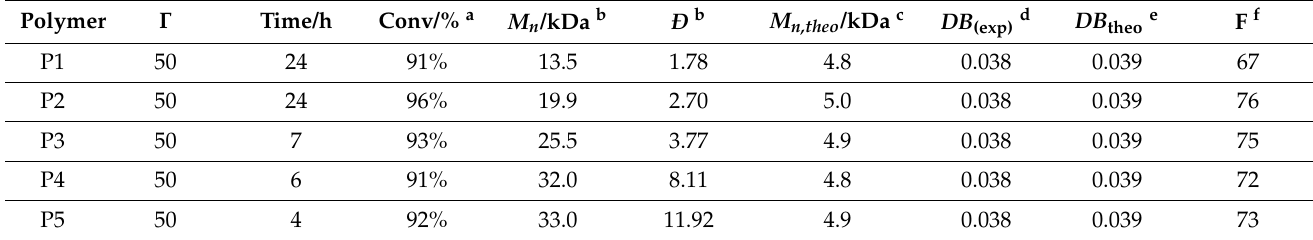
Table 1. Results of RAFT-SCVP copolymerization of DMA with VBPC in dioxane at 60 ◦ C at γ =